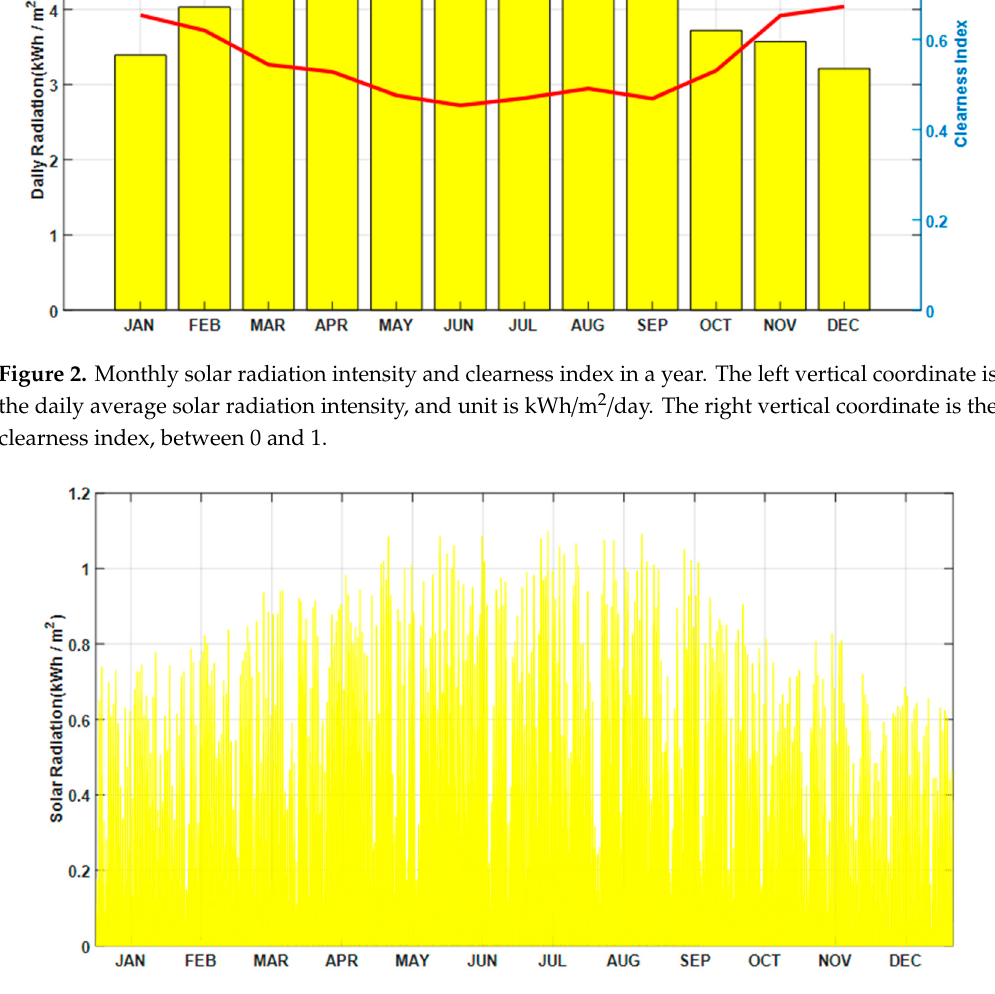
Table 3. PV output power (kW) at each scenario and each time.